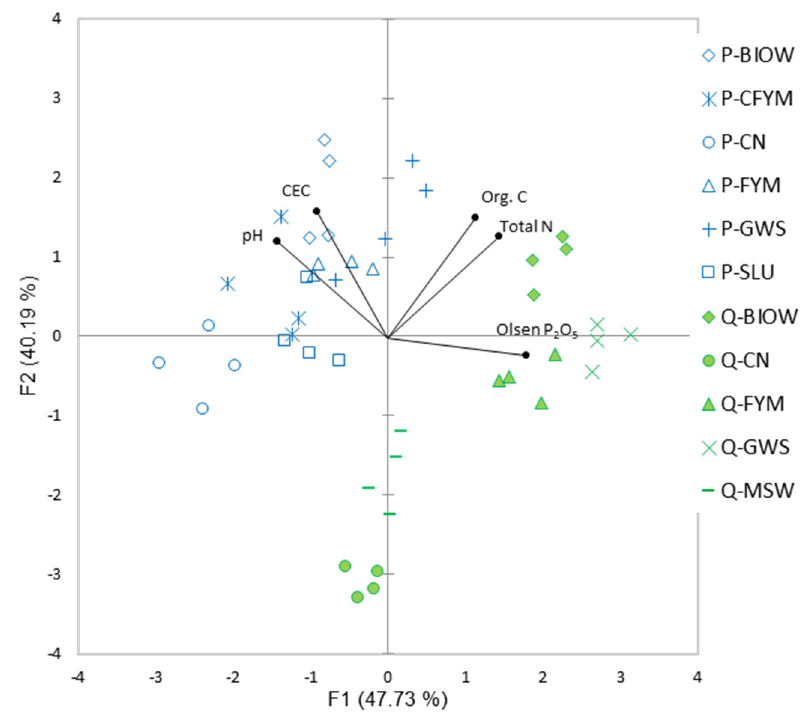
Figure 3. Principal component analysis of soil chemical properties for both experimental sites, after 13–15 years of OWP spreading ( n = 44); see Figures 1 and 2 for treatments signification. Soil OC, CEC and pH are known to be increased by the repeated inputs of OWP and to influence TE mobility and bioavailability [24,26,37,59]. As observed in Table 4 and illustrated by the distribution of the dots in PCA analysis for both sites (Figure 3), the increase of those properties was more marked at QualiAgro site compared to the PROspective site. As supposed by the first working hypothesis, this observation could result from initial soil chemical properties, such as pH, OC content and CEC higher at the PROspective site compared to the QualiAgro site, and from the higher amounts of OWP applied at QualiAgro site compared to the PROspective site. Moreover, the PROspective site presented a high pH buffering capacity, notably in relation to its carbonate content. At both sites, initial topsoil TE concentrations were homogeneous as no significant difference was observed between the treatments plots (detailed statistics in Supplemen- tary Materials Table S1). At the QualiAgro site, initial TE concentrations were in the range or lower than median values for topsoil layer (0–30 cm) of arable crop systems cited in Saby et al. [58], except for Hg (Table 5). At the PROspective site, initial TE concentrations were close to the median or lower than those commonly found in topsoil in France for Cd,